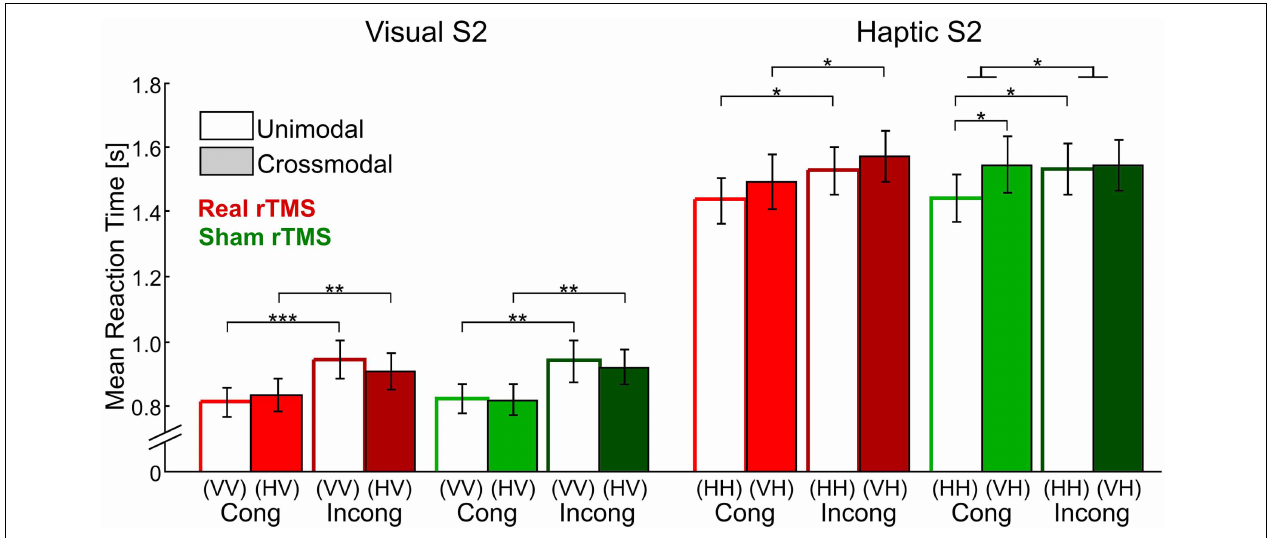
FIGURE 3 | Mean reaction times for visual and haptic S2 for all four delayed matching conditions (unimodal/crossmodal × congruent/incongruent) and after real (red bars) and sham rTMS (green bars) conditions. Error bars indicate the standard error of the mean.